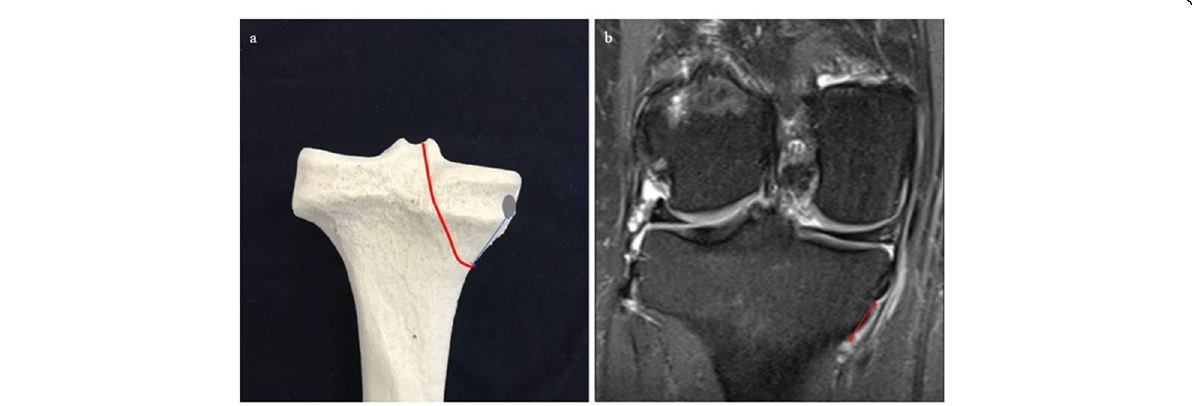
Fig. 5 a IMGA – SMT Cor (blue) drawn on a 3D model. IMGA course in red. Semimembranous tendon in grey. b . IMGA-SMT Cor on T2w with fat suppression coronal sequence (red)